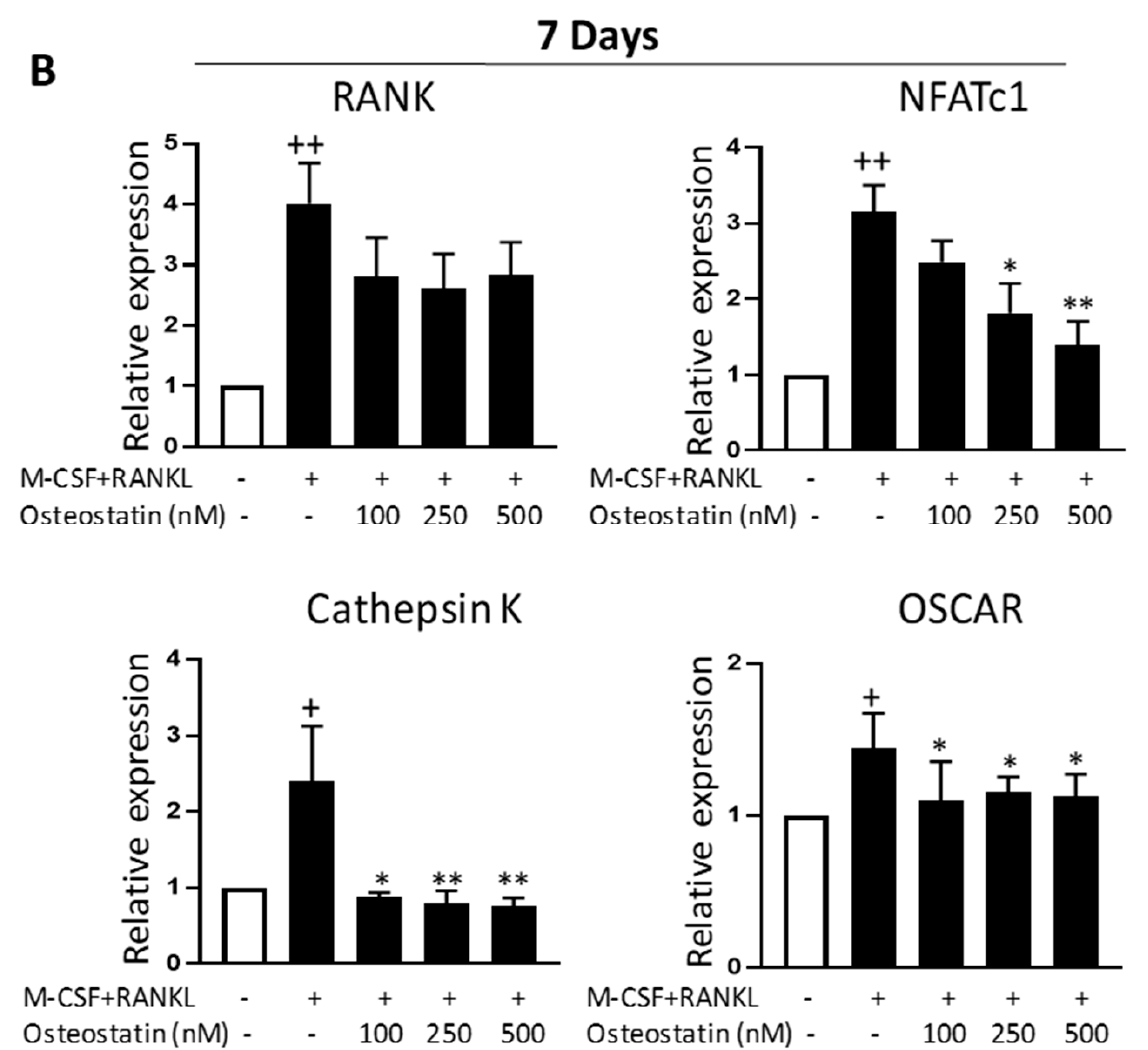
Figure 3. The effects of osteostatin on the mRNA expression of osteoclast markers. ( A ) Expression levels at 2 days of differentiation. ( B ) Expression levels at 7 days of differentiation. Osteoclast pre- cursors were incubated with M-CSF and RANKL in the presence or absence of osteostatin (final concentrations: 100, 250 and 500 nM). The levels of mRNA expression were determined with qRT- PCR and normalized to glyceraldehyde-3-phosphate dehydrogenase (GAPDH). Values are the mean ± S.D. of four independent experiments; + p < 0.05, ++ p < 0.01 vs. control; * p < 0.05, ** p < 0.01 vs. M-CSF+RANKL.